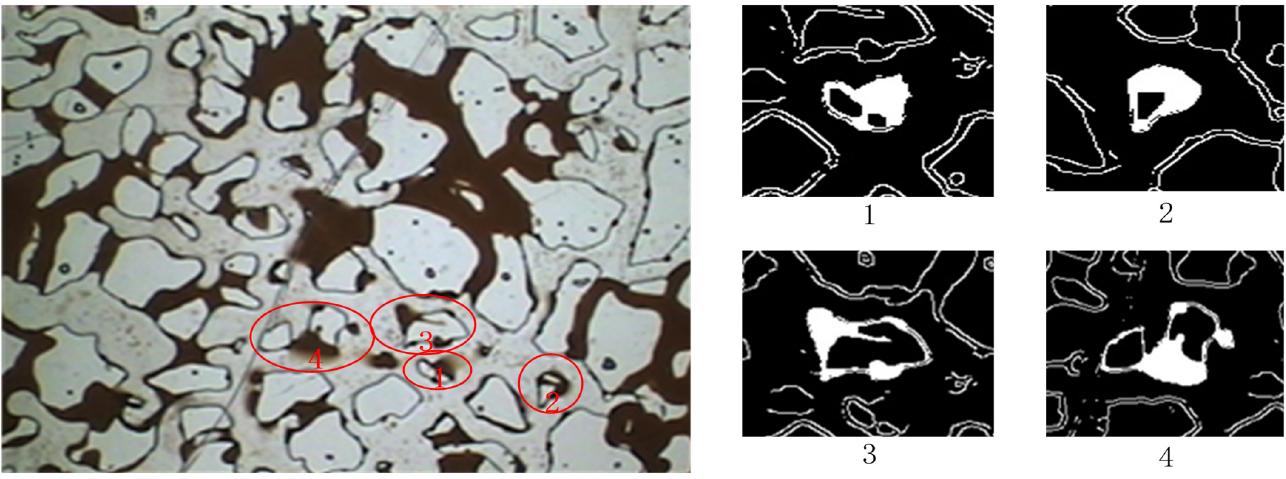
Figure 7. Preprocessing effect diagram.